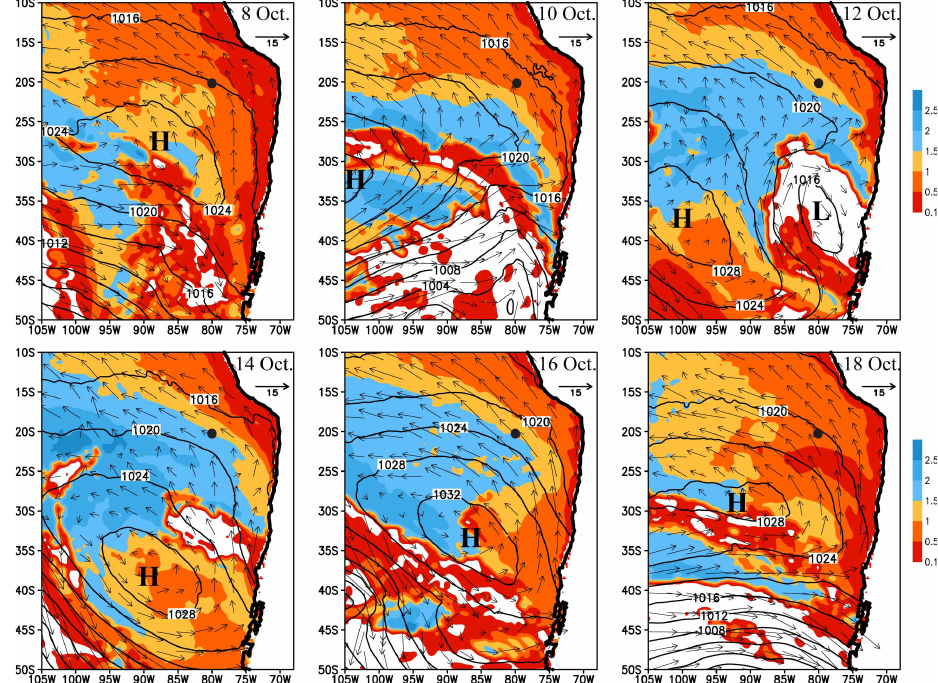
Fig. 13. WRF-simulated sea level pressure (contours, hPa), MBL height (color, km), and wind (ms − 1 ) at 12;00UTC for several days (dates indicated in each panel). Wind is at the MBL top when MBL is defined and at the surface when not